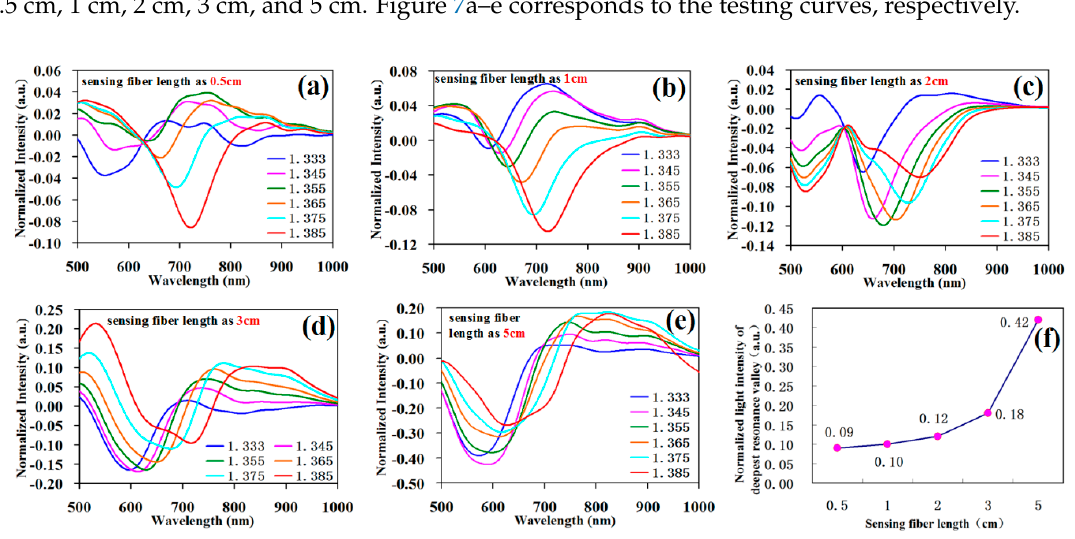
Figure 7. Testing data of the sensing fiber SPR with different lengths. ( a ) Experimental data of the sensing fiber length of 0.5 cm; ( b ) experimental data of the sensing fiber length of 1 cm; ( c ) experimental data of the sensing fiber length of 2 cm; ( d ) experimental data of the sensing fiber length of 3 cm; ( e ) experimental data of the sensing fiber length of 5 cm; ( f ) normalized light intensity of the deepest resonance valley corresponding to the sensing fibers of different lengths.